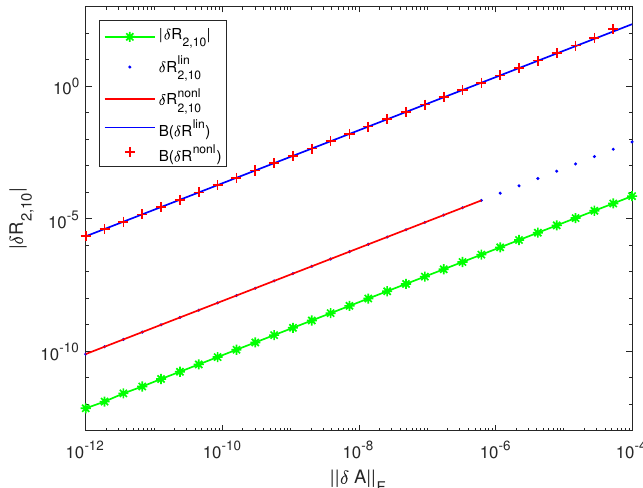
Figure 8. Exact values of δ R 2,10 and its bounds as functions of the perturbation